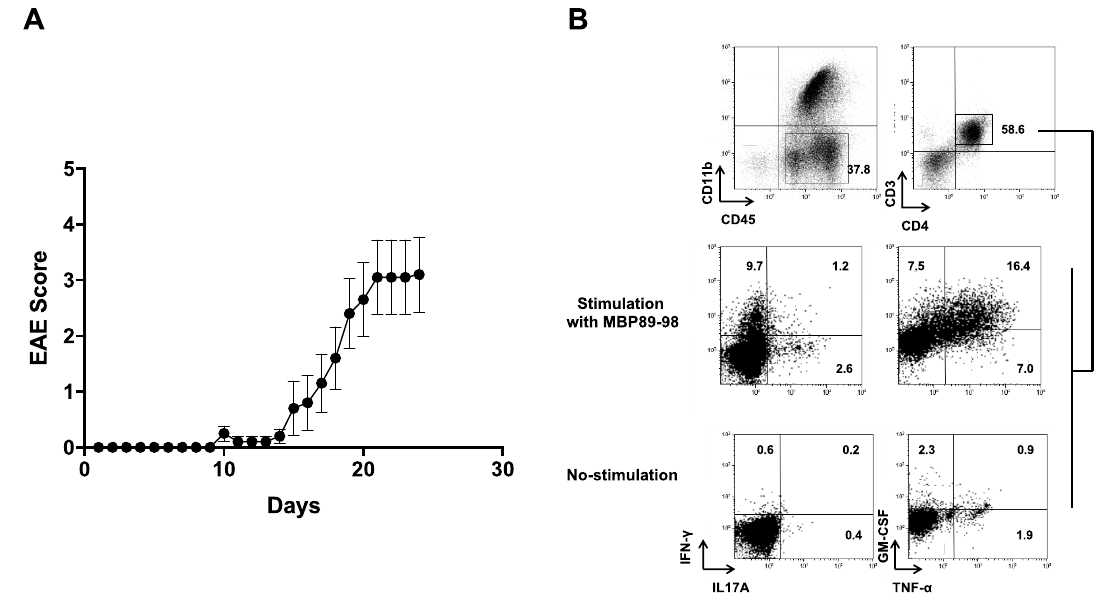
Figure 4. Induction of EAE in MBP-TCR/DR2a Tg mice upon immunization with C. difficile DJNS06-36 SLPA protein. ( A ) MBP-TCR/DR2a Tg mice ( n = 10) were immunized with LMW-SLPA/CFA and development of EAE was examined. The combined data from two independent experiments is presented. ( B ) Development of Th1 and Th17 cells in EAE mice. Spinal cords isolated from EAE mice were stained with CD11b, CD45, CD4, CD3, IL-17A, and IFN-γ mAbs. CD45 + CD11b − CD3 + CD4 + T cells were gated and examined for development of Th1 (IFN-γ + ), Th17 (IL-17A + ), and ThGM (GM-CSF + ) cells.